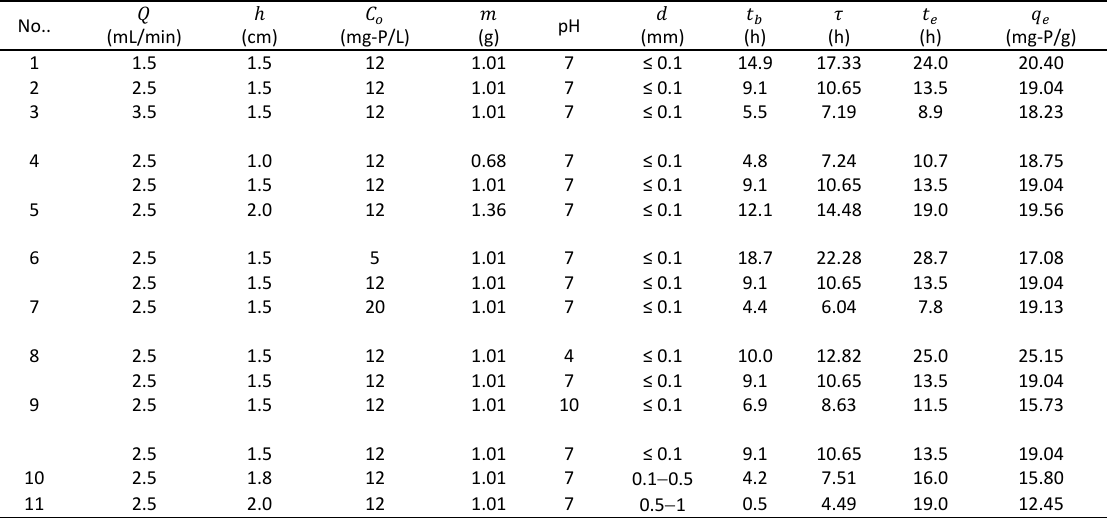
Table 1: Fixed-bed column parameters for phosphate adsorption on am-Zr/MgFe-LDH composite